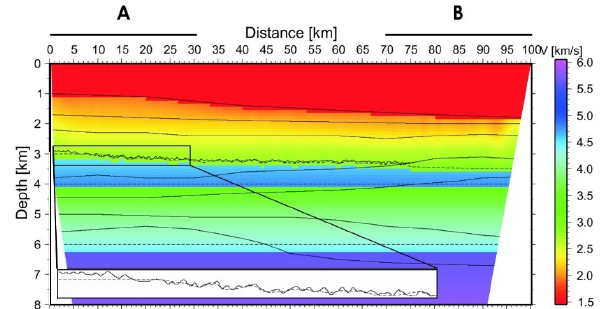
Fig. 5. Results from the basalt refraction inversion. White dashed lines represent layers from inversion and continuous lines the theo- retical layer interfaces. The base of the basalt layer, which is overes- timated, should be delineated by raypaths. The black area represents the part of the model sampled by